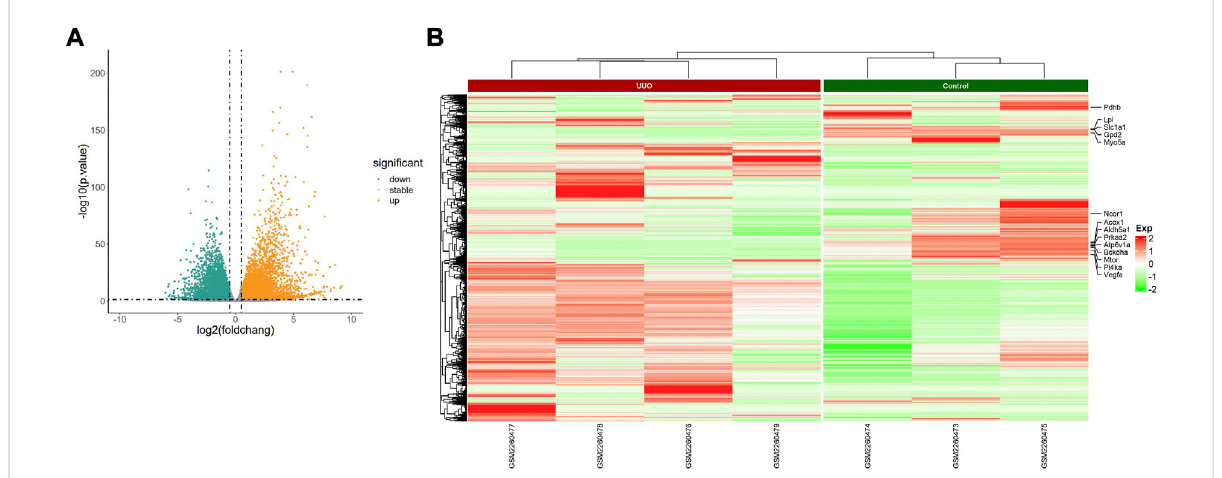
FIGURE 4 Pro fi ling of DEmRNAs in the UUO group and control group in GSE85209. (A) Volcano plots. Orange represents upregulation and green represents downregulation. (B) Heatmaps. Red represents upregulation and green represents